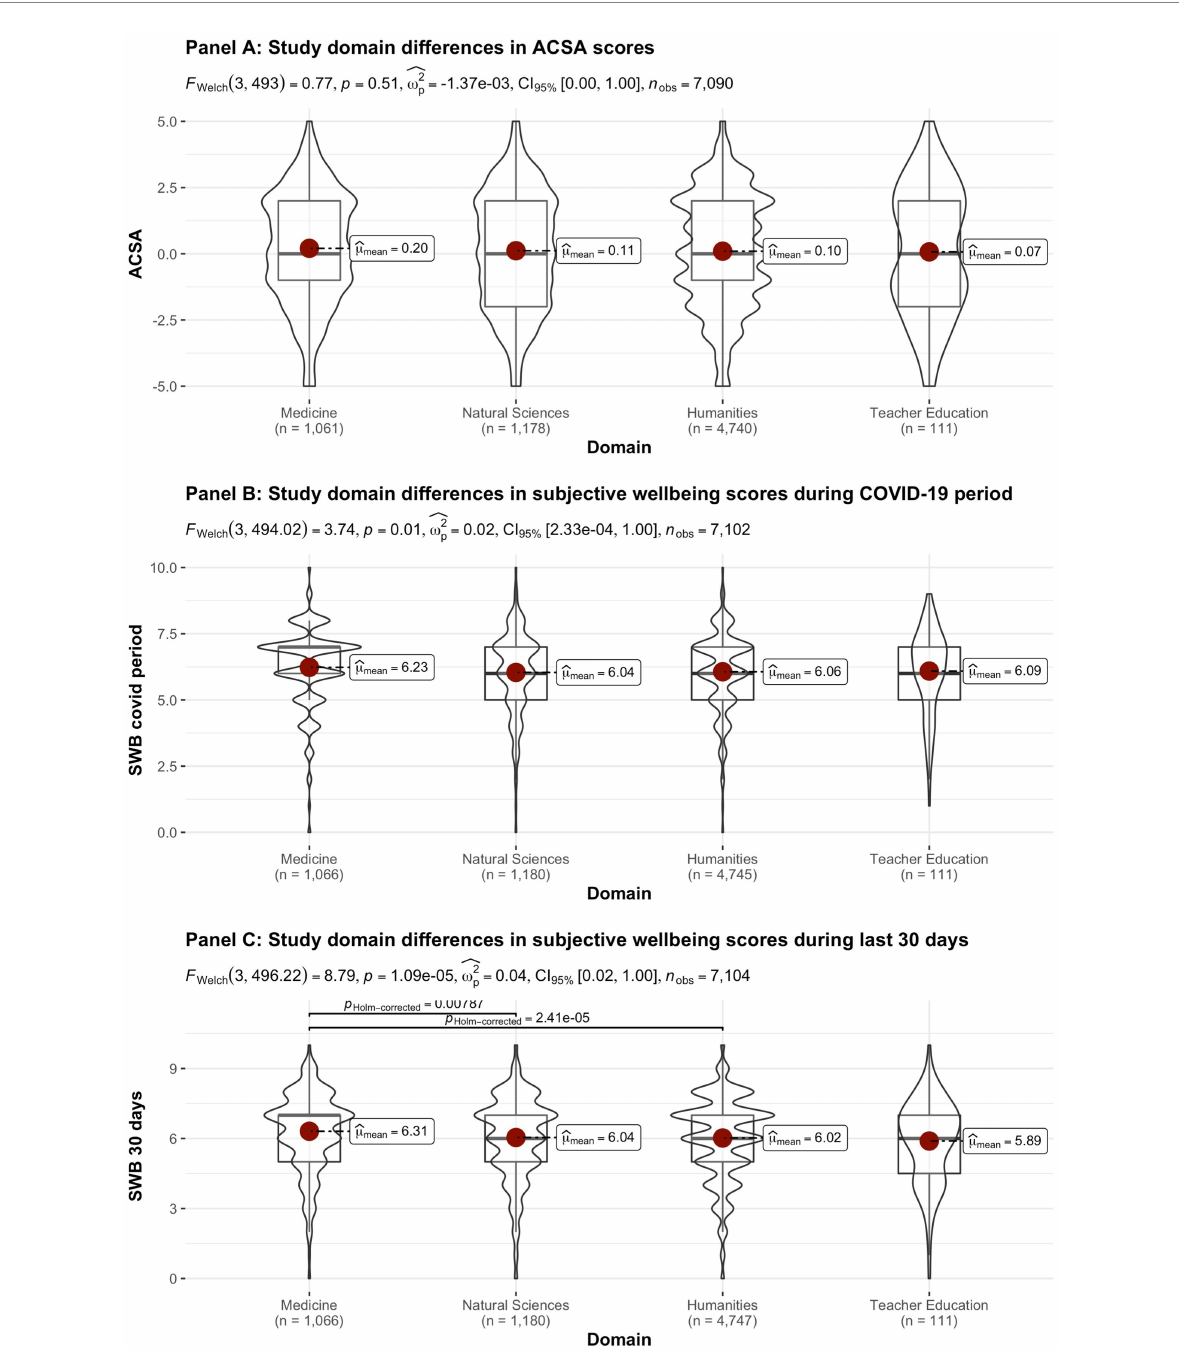
FIGURE 7 Mean ACSA (during the last 2 weeks, on a − 5 to +5 scale) and SWB-scores (during the COVID-19 period, and during the past 30 days, both on a 0–10 scale) comparing student groups during COVID-19 in terms of study